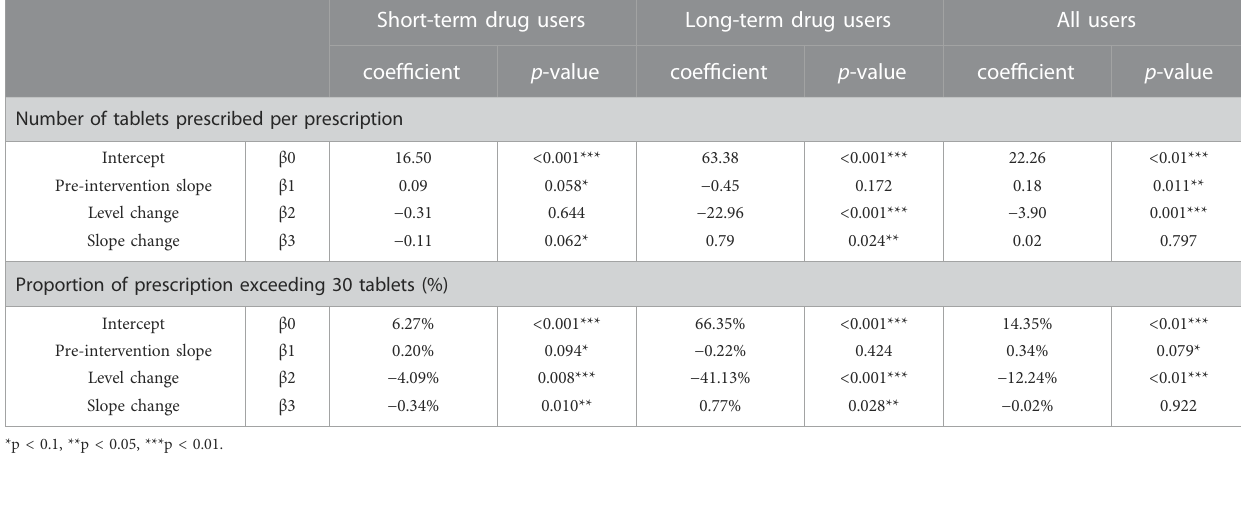
TABLE2EstimatesfromInterruptedTime-Seriesmodelsoftheimpactsofthepolicyonthenumberoftabletsprescribedandproportionofprescriptionexceeding 30 tablets.